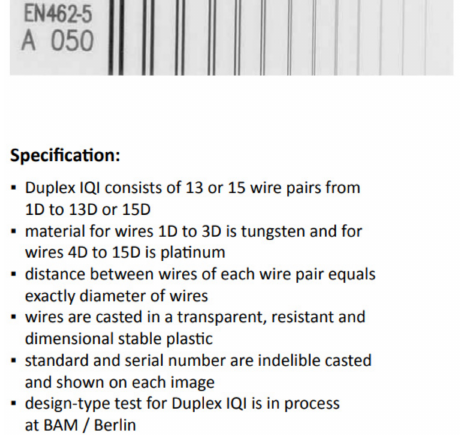
Figure 1. Specification of duplex wire-type IQI. Measurement and calculation procedure for SR detector